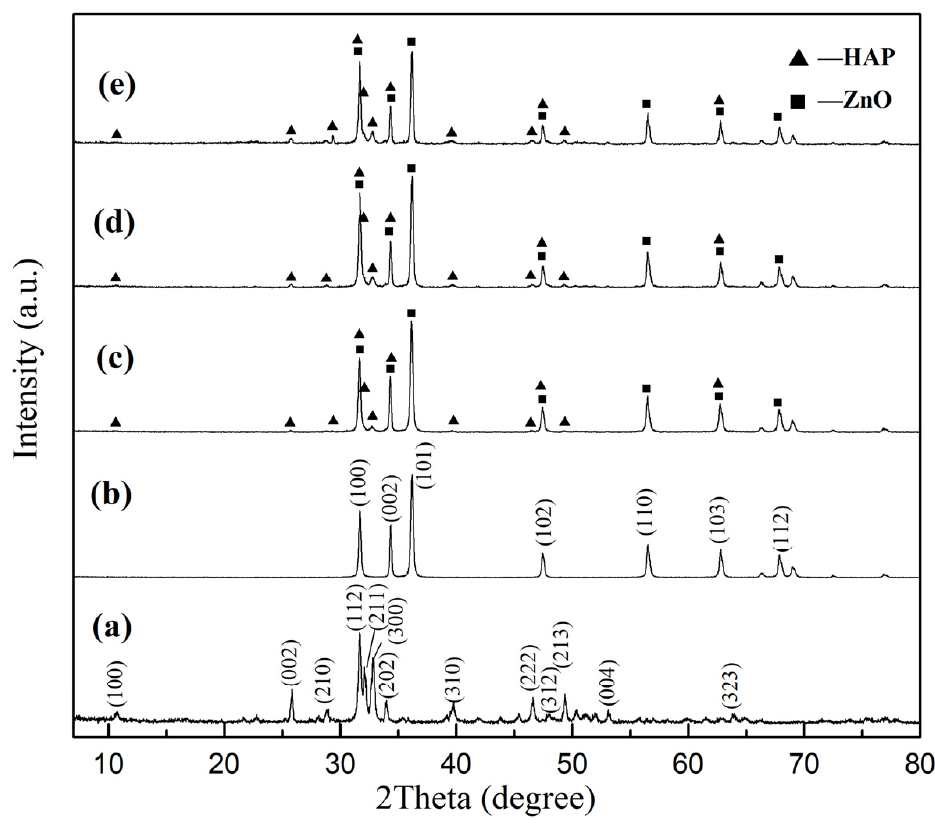
Figure 2. XRD patterns of samples ( a ) HAP, ( b ) ZnO, ( c ) ZnO-HAP (80 wt.% ZnO + 20 wt.% HAP), ( d ) ZnO-HAP (65 wt.% ZnO + 35 wt.% HAP), and ( e ) ZnO-HAP (50 wt.% ZnO + 50 wt.% HAP).